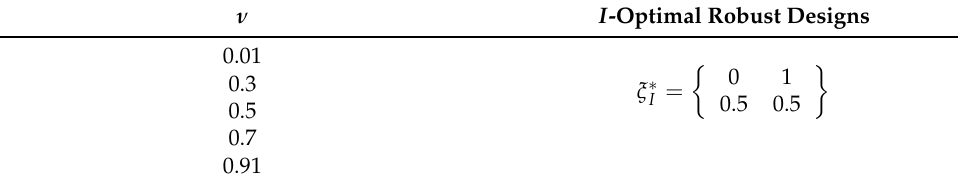
Table 3. 2-point I -optimal robust designs computed for the log-logistic model.